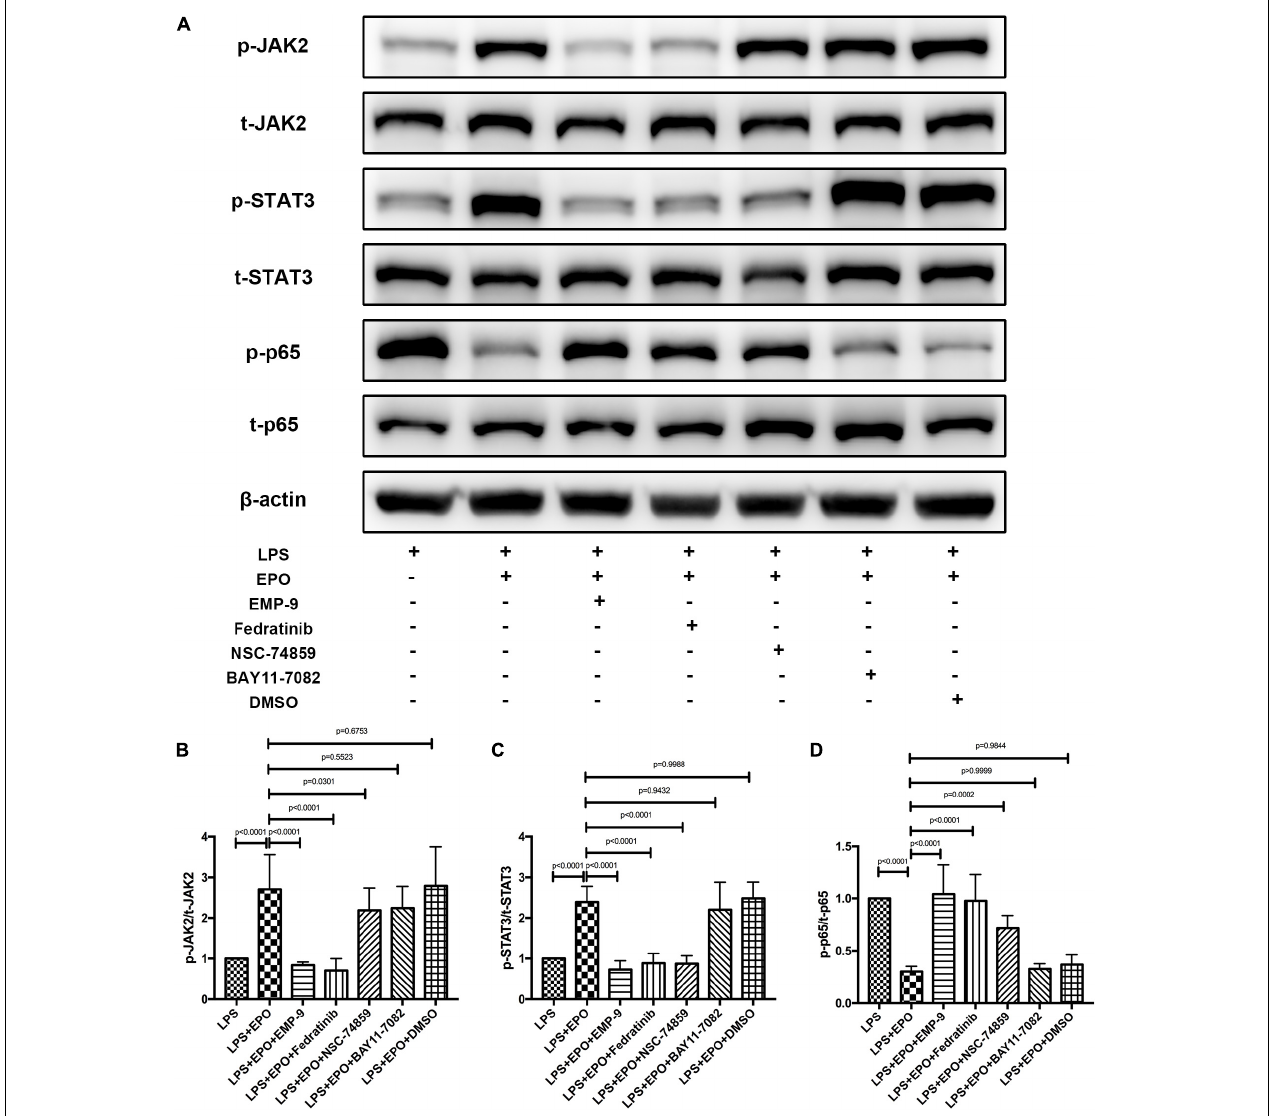
FIGURE 5 | The protective effects of EPO on acute lung injury were EPOR/JAK2/STAT3/NF- κ B signaling axis dependent. EMP9 (an EPOR antagonist, 1 mg/mouse), Fedratinib (a JAK2 inhibitor, 100 mg/kg), NSC 74859 (a STAT3 inhibitor, 5 mg/kg), BAY 11-7082 (an NF- κ B inhibitor, 20 mg/kg), and DMSO (solvent of inhibitors) were injected into the peritoneal cavity 30 min before EPO treatment. Then, EPO (5 U/g) was injected into the peritoneal cavity of mice after LPS (15 mg/kg) stimulation, and the mice were sacrificed 8 h later. The lung tissues were harvested to measure the protein expression of p-JAK2, t-JAK2, p-STAT3, t-STAT3, NF- κ B p-p65, and NF- κ B t-p65 (A–D) by Western blotting. The data are presented as the mean ± SD. The differences among groups were assessed by one-way ANOVA and the post hoc test (Turkey method) was applied to investigate the differences one by one. n = 8 per